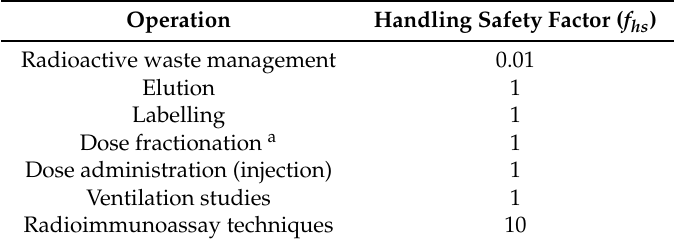
Table 2. Standard handling safety factors based on the nature of the operation [8,25].